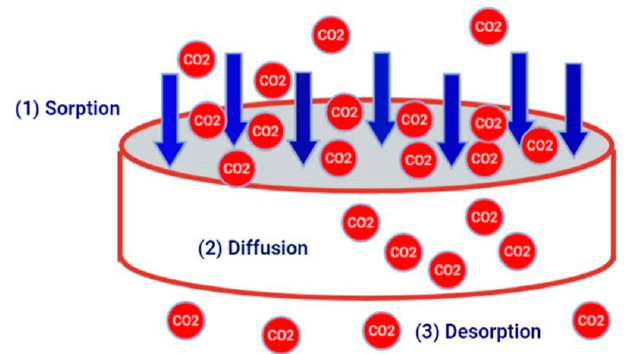
Figure 5. Solution-diffusion model for gas separation.